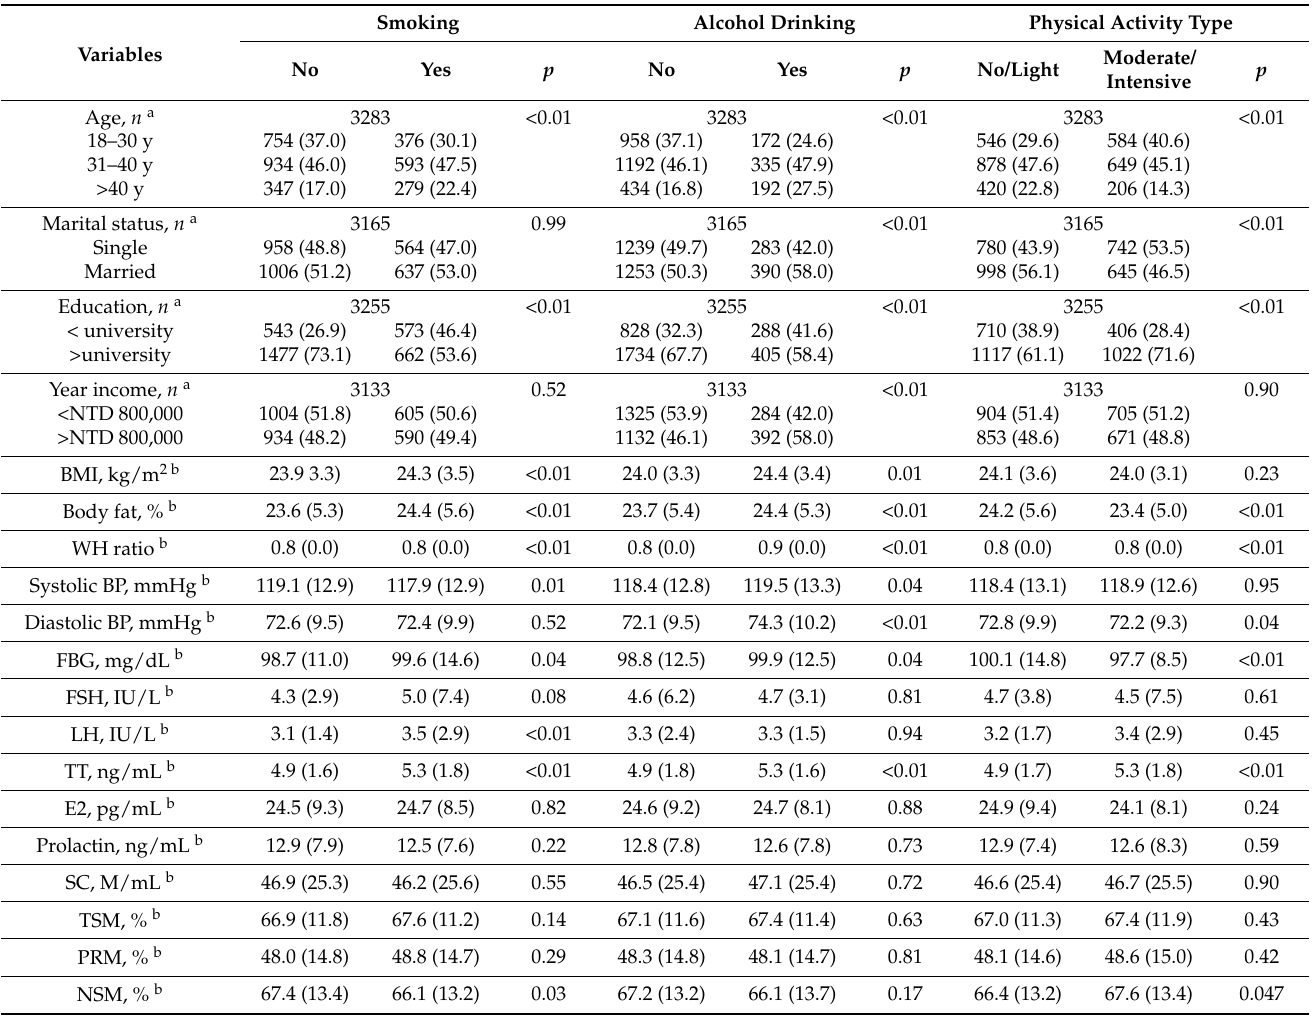
Table 1. Characteristics of men according to smoking, drinking, and physical activity